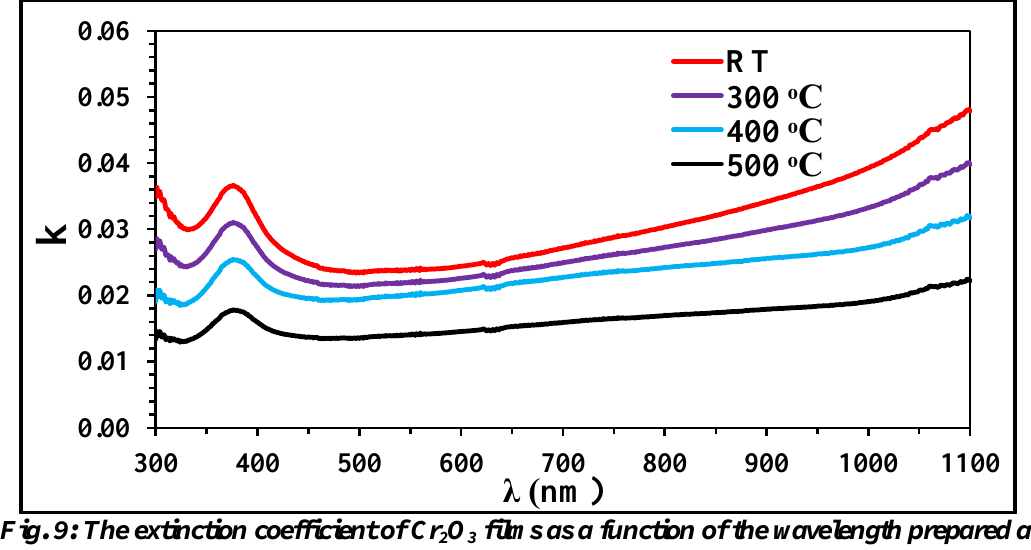
Fig. 9: The extinction coefficient of Cr